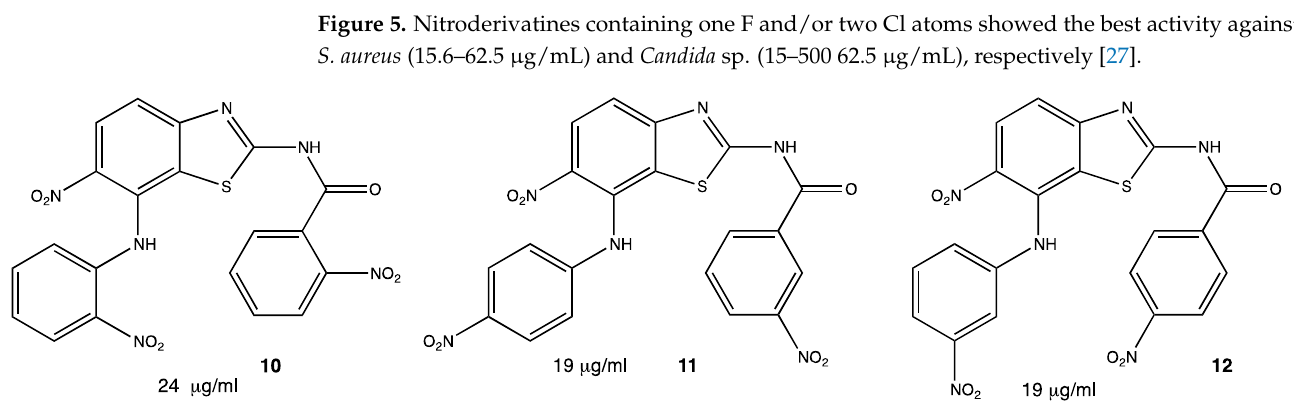
Figure 6. Benzothiazole derivatives against P. aeruginosa [28].